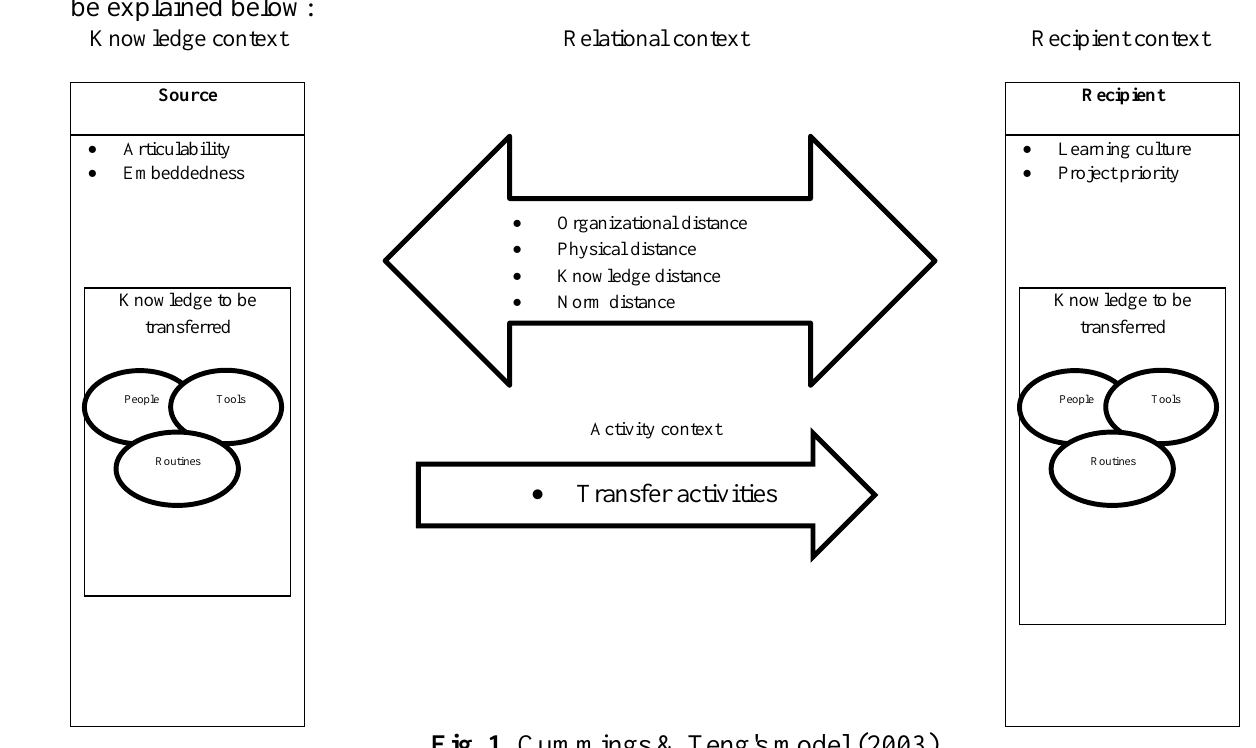
Fig. 1. Cummings & Teng's model